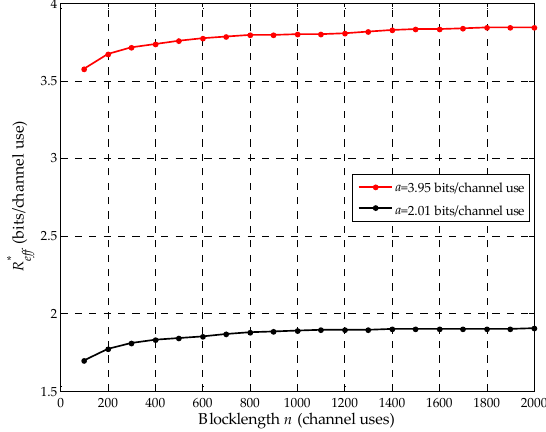
Figure 5. R ∗ vs the blocklength n ef f Figure 5. * R vs the blocklength n . eff